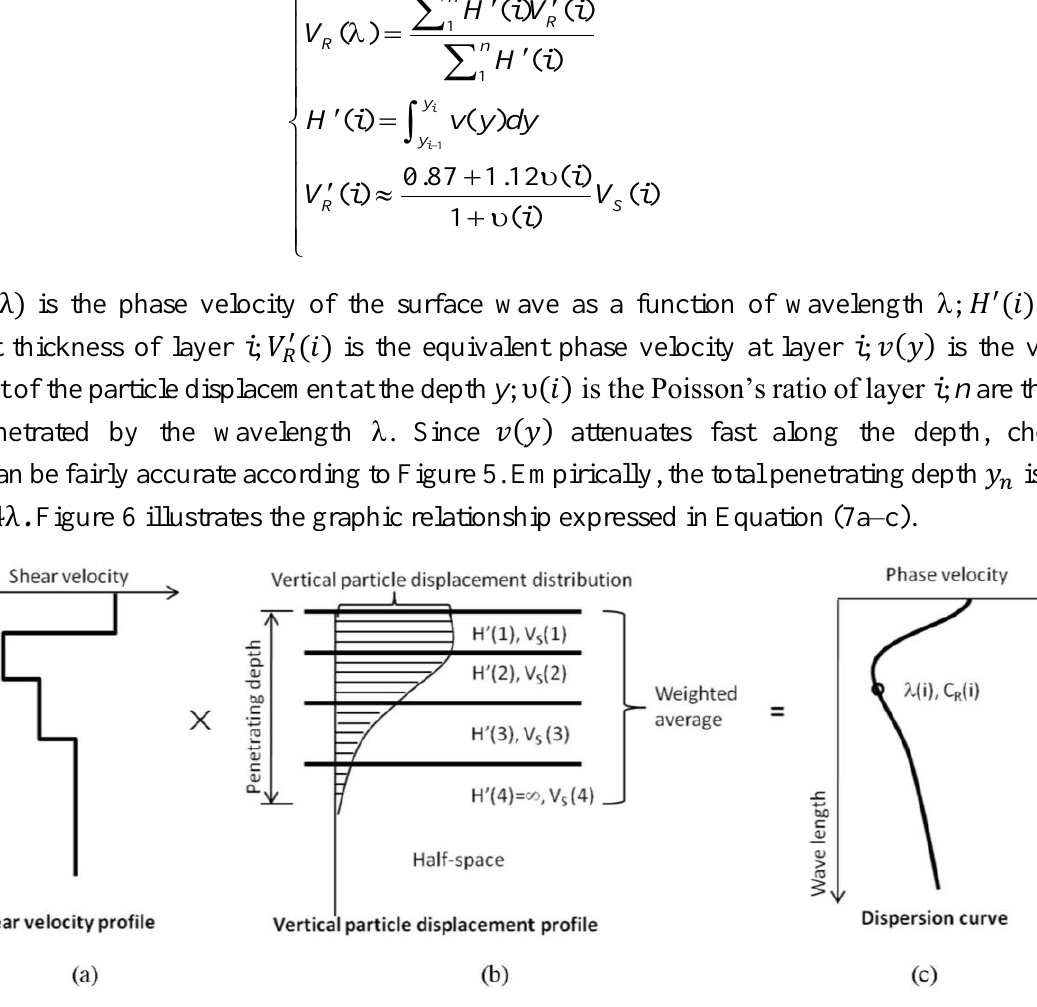
Figure 6. Relationship between shear velocity profile and dispersion curve for layered system; ( a ) Shear velocity profile; ( b ) Particle displacement; and ( c ) Dispersion